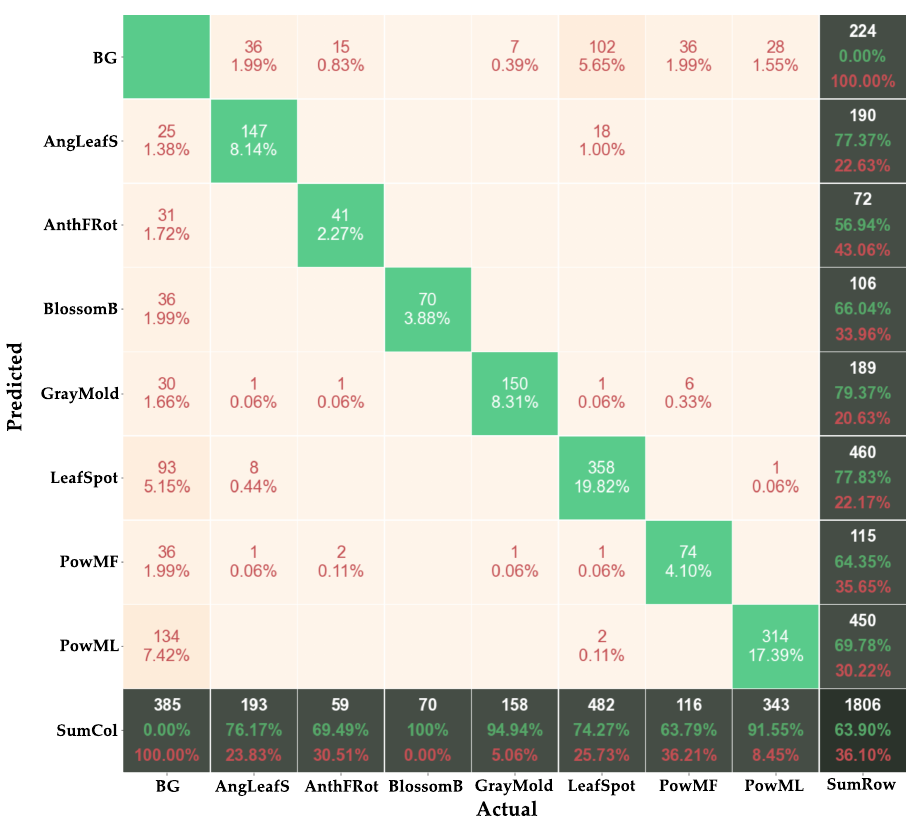
Figure 7. Confusion matrix of the Strawberry Diseases segmentation results (including Background, which covers the cases of model misses, i.e., detecting BG instead of an actual object or vice versa). Green Boxes: True Positives; Peach Boxes: Misclassifications (False Negatives, False Positives).